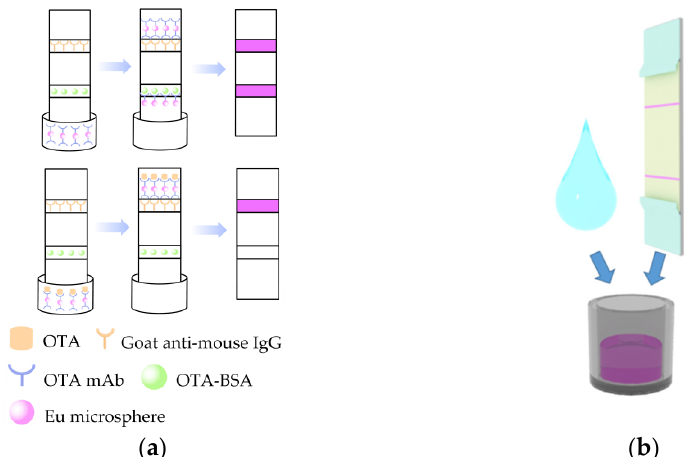
Figure 2. ( a ) Schematic illustration of the iPOCT strips. ( b ) The solid phase MAb@Eu-nanospheres in the well microplate were prepared by freeze-drying the reaction products after adding 20 µL of OTA-Mab (1 mg/mL) into 200 µL of Eu-nanospheres.